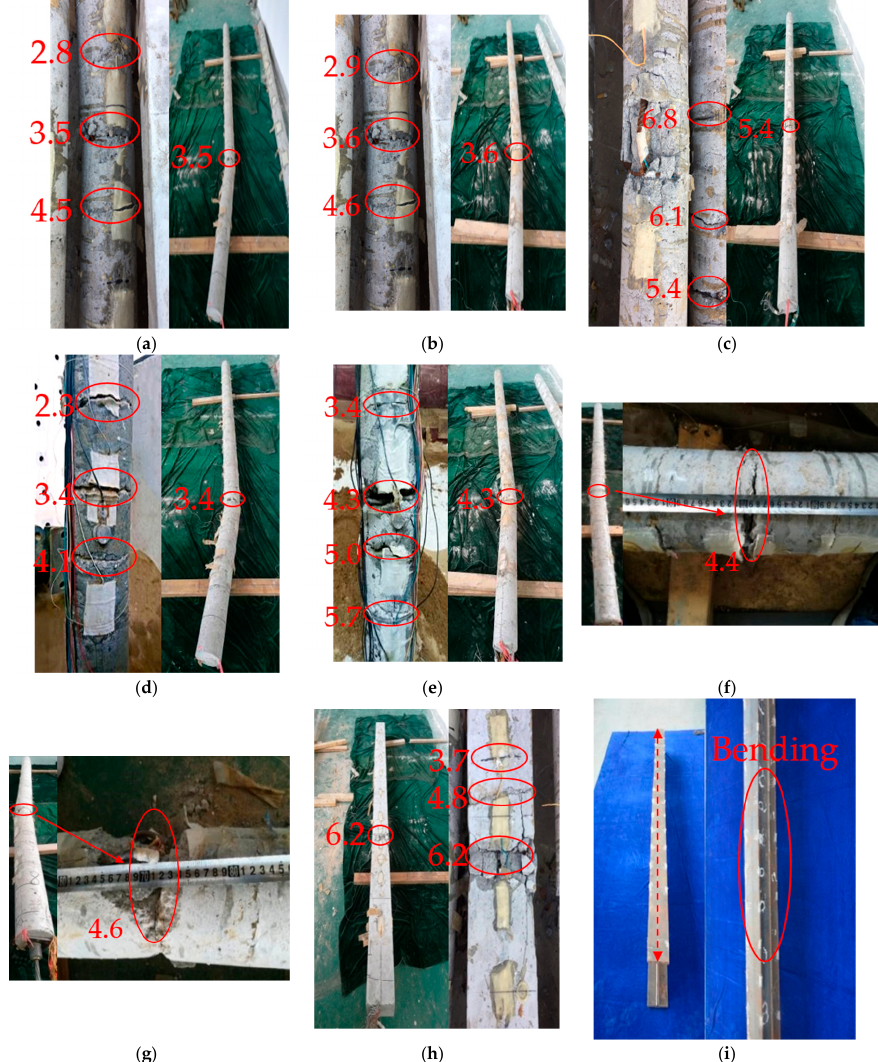
Figure 8. Specimens’ failure modes. ( a ) CP-1 specimen. ( b ) CP-2 specimen. ( c ) CP-3 specimen. ( d ) CP-4 specimen. ( e ) CP-5 specimen. ( f ) PC-6 specimen. ( g ) PC-7 specimen. ( h ) RP-8 specimen. ( i ) HP-9 specimen.